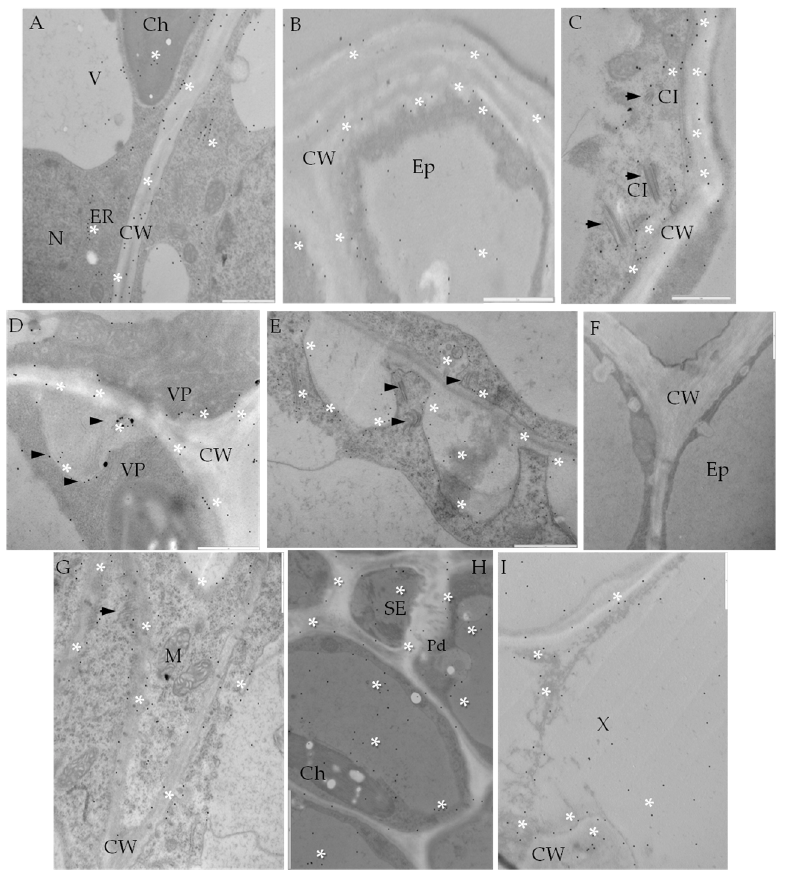
Figure 7. Immunogold labeling of CesA4 in potato–PVY NTN compatible ( B – E ) and incompatible interaction ( F – I ). ( A ) Gold deposition (*) of CesA4 along cell wall, plasmolema and ER in mesophyll cells of potato mock-inoculated. Bar 1 µ m. ( B ) CesA4 deposition (*) in cell wall and vacuole of epidermis cell. Bar 1 µ m. ( C ) CesA4 deposition along cell wall and membranous structures associated with virus cytoplasmic inclusions (arrows). Bar 1 µ m. ( D ) CesA4 localization (*) along cell wall in potato Irys mesophyll cells. Virus particles around plasmodesmata, gold deposition in area of protoplast retraction from the cell wall (arrow). Bar 1 µ m. ( E ) CesA4 localization (*) in xylem tracheary elements. Deposition along cell wall, membranous structures associated with virus inclusions (arrows) and trans Golgi network. Bar 1 µ m. ( F ) Control—lack of gold deposition in hypersensitive response when primary antibodies were omitted. Bar 1 µ m. ( G ) CesA4 localization (*) along plasma membrane structures and plasmalema (also in connection with cytoskeleton, arrow). Bar 1 µ m. ( H ) Gold deposition (*) in cell wall associated with plasmodesmata in sieve element in hypersensitive reaction.